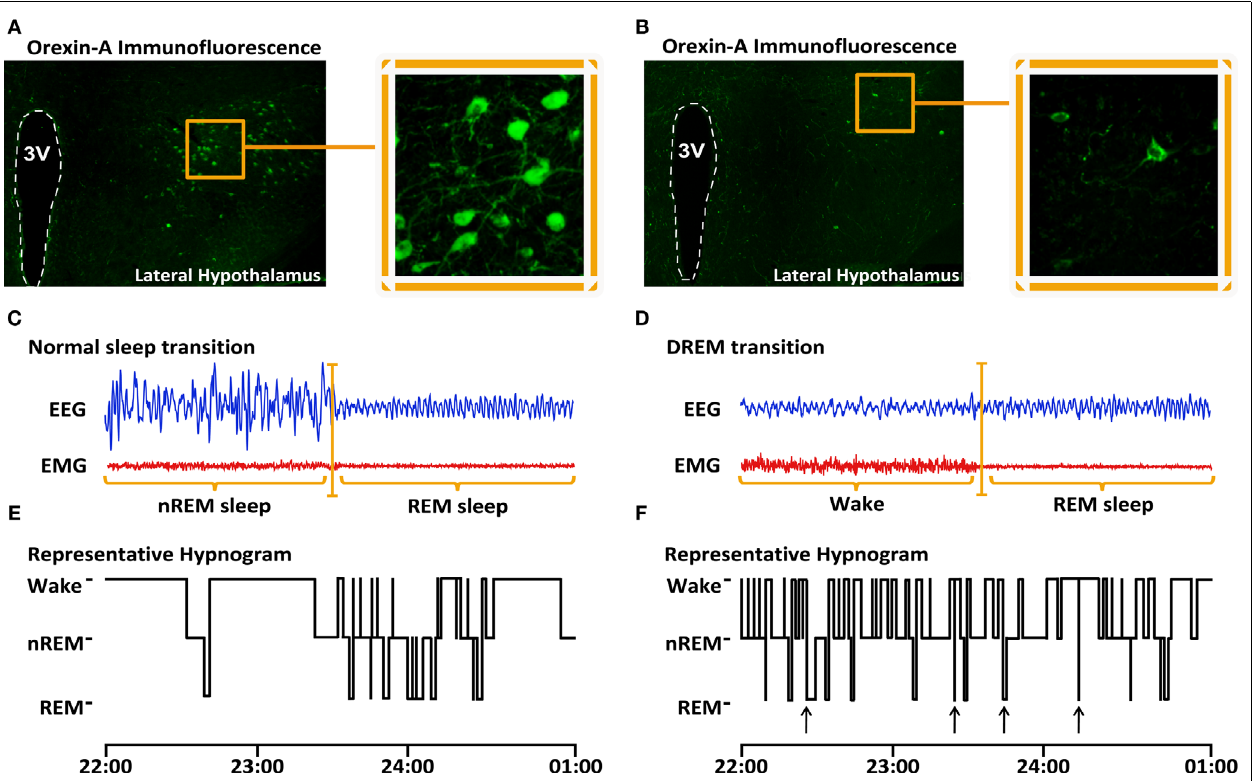
REM sleep obtained during the dark period fromWt mice reveal that REM sleep is preceded by nREM sleep (C) . Representative recordings from O/E3-null animals show direct transitions to REM sleep (DREM), where REM sleep is immediately preceded by an epoch of wake (D) . Representative hypnograms derived from the EEG/EMG recordings show multiple DREM episodes occurring in O/E3-null mice (G) , while none can be detected in Wt animals (F)